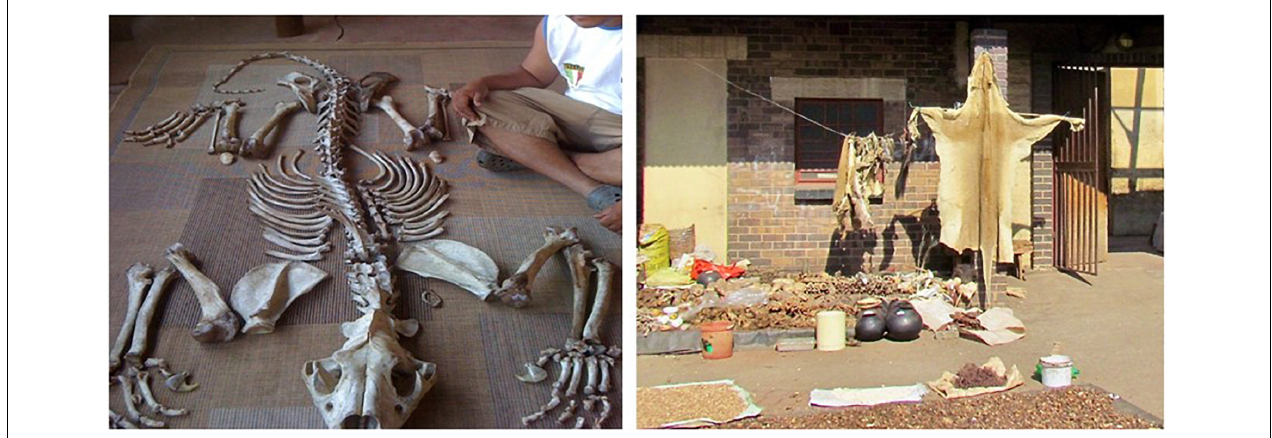
FIGURE 5 | Lion parts and derivatives on sale at an unknown location in South Africa (left) and Kwa Mai Mai traditional medicine market in Johannesburg South Africa (right). ©